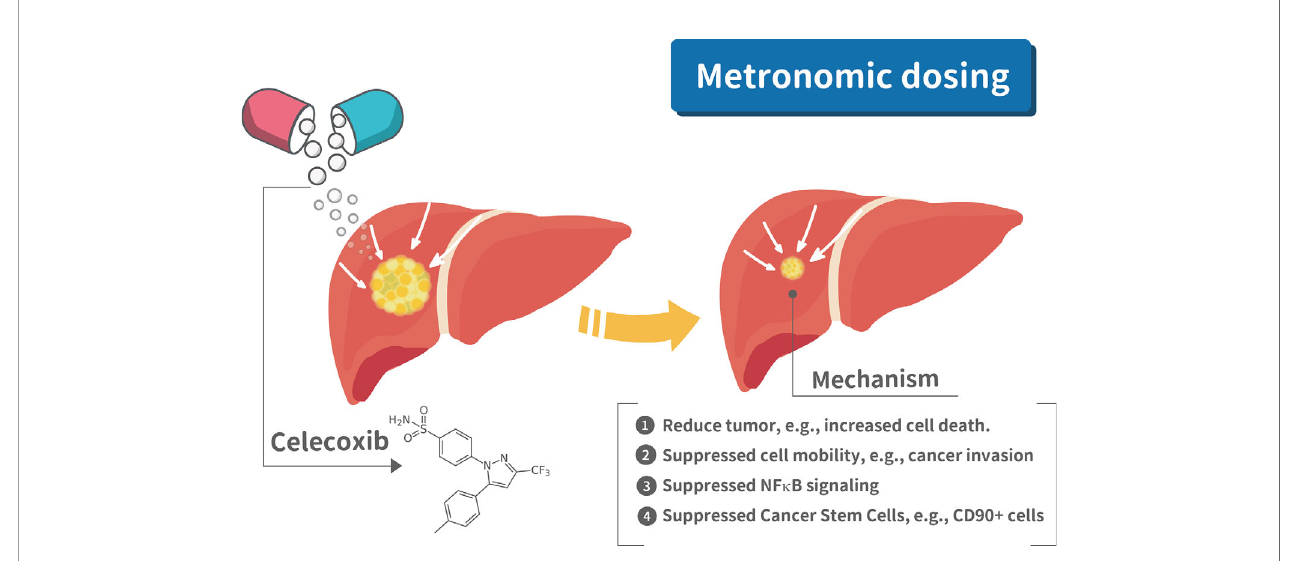
FIGURE 8 | Mechanistic illustration of metronomic celecoxib effects on suppressing HCC prognosis. There are four mechanism for metronomic dosing in suppressing HCC prognosis, e.g., 1. Reduced tumor growth; 2. Suppressed cell mobility; 3. Suppressed NFkB signaling; 4. Suppressed cancer stem